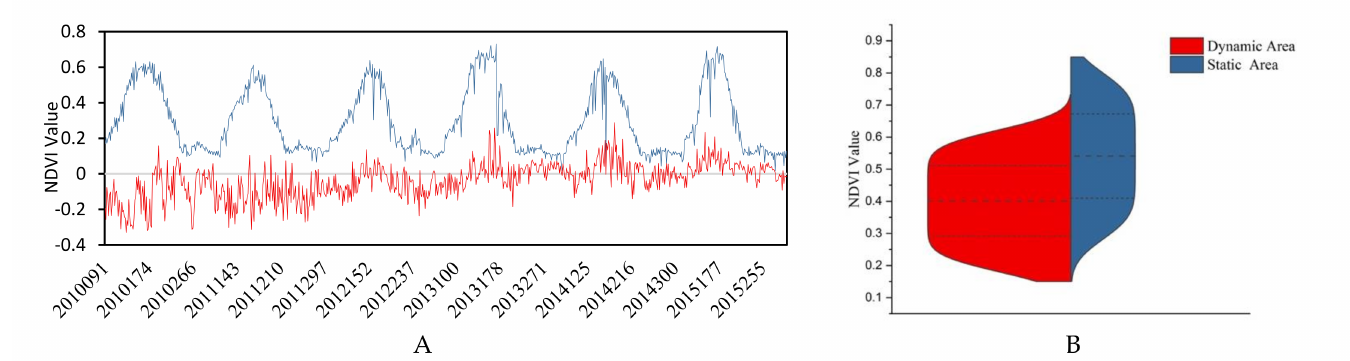
Figure 8. Spatial distribution patterns of the peak NDVI values in the study area ( A ) and categories of different zones ( B ), S1 represents the continuously inundated floodplain area, S2 is the frequently inundated floodplain area, S3 represents the regularly inundated floodplain area, and S4 represents the extremely rare inundated floodplain